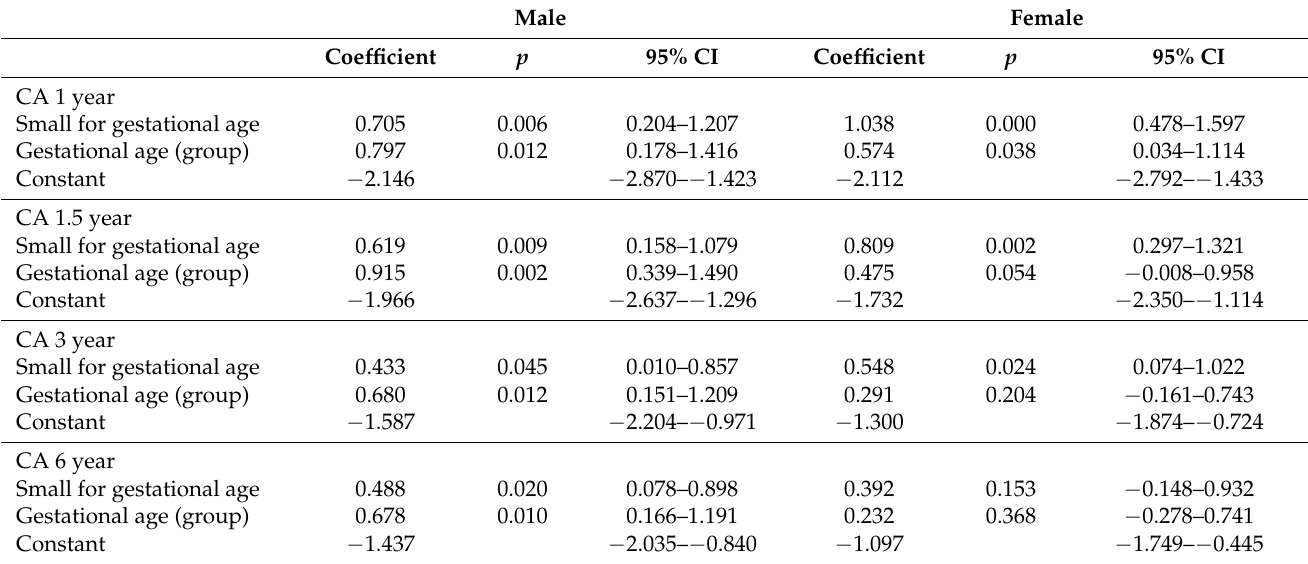
Table 3. Linear regression analysis to determine the association between body length z-scores and the presence of small for gestational age and two gestational age groups.